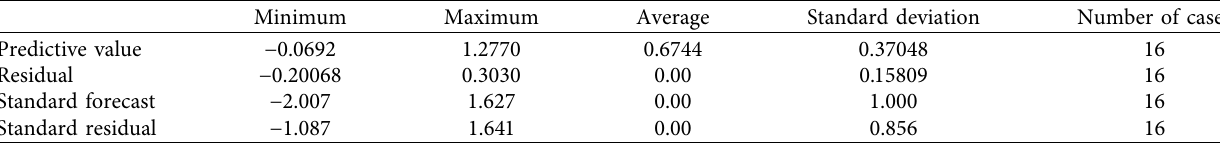
Table 9: Residual statistics.